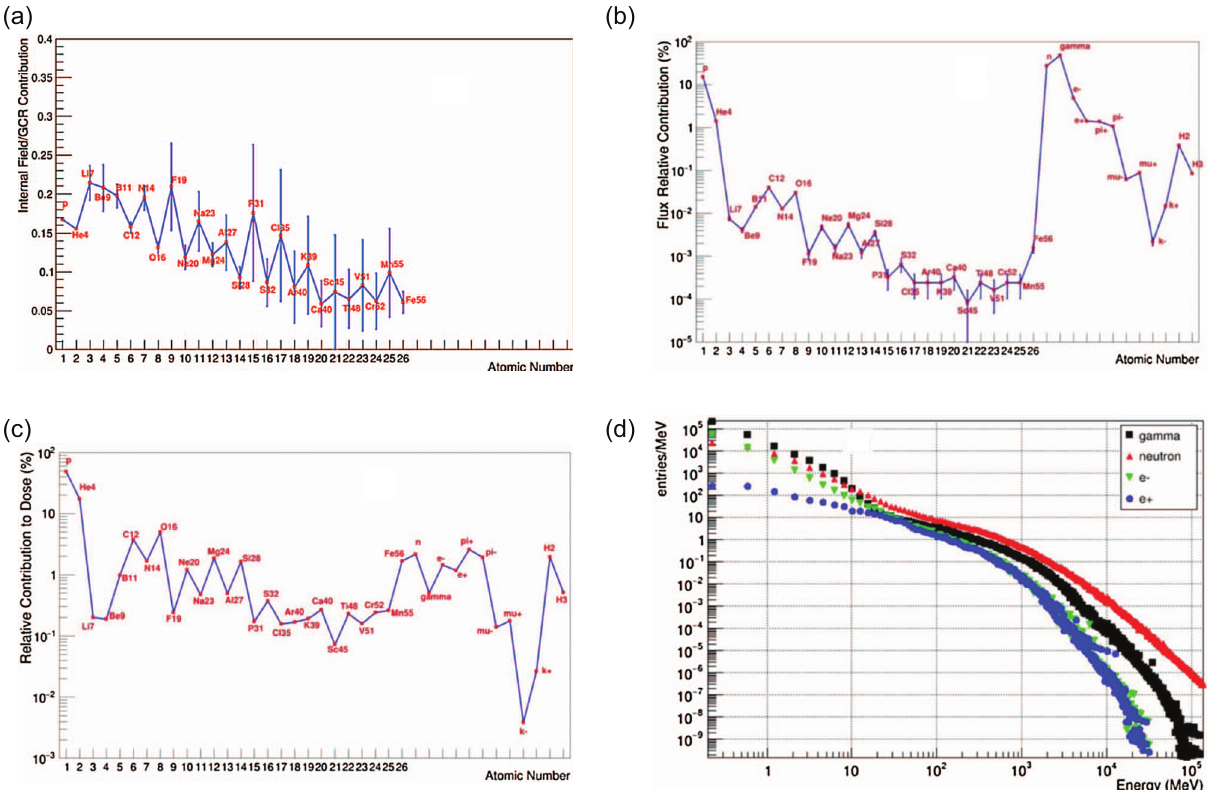
Fig. 5. (a) For the particles with Z = 1 to Z = 26 the ratio of their contribution in the integrated fl ux of the spacecraft internal fi eld over their contribution in the integrated fl ux of the GCR fi eld is shown. (b) The relative contribution of the particles in the integrated fl ux of the spacecraft ’ s internal radiation fi eld is presented. (c) The relative contribution to dose in water of the particles of the spacecraft internal radiation fi eld. (d) Energy spectra for gammas, neutrons, electrons, and positrons, which are the most abundant species in the internal fi eld.